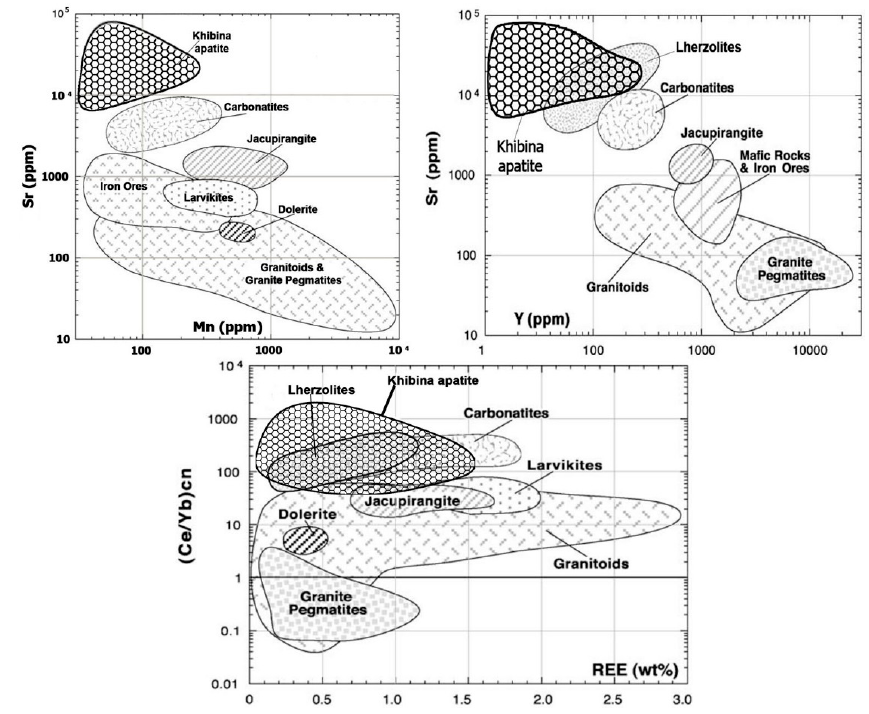
Figure 6. Compositional Field of Khibiny apatite on the discriminant diagrams proposed by [37].